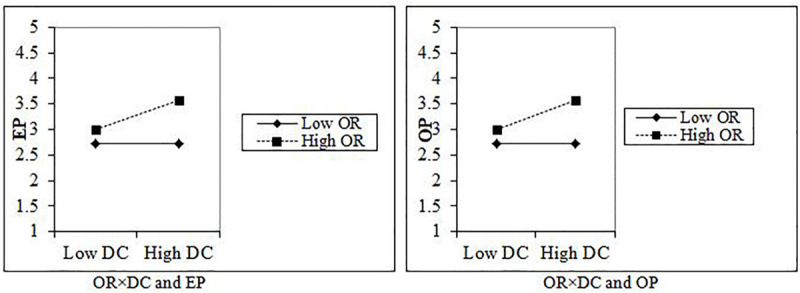
Interaction of OP and DC with EP and OR.